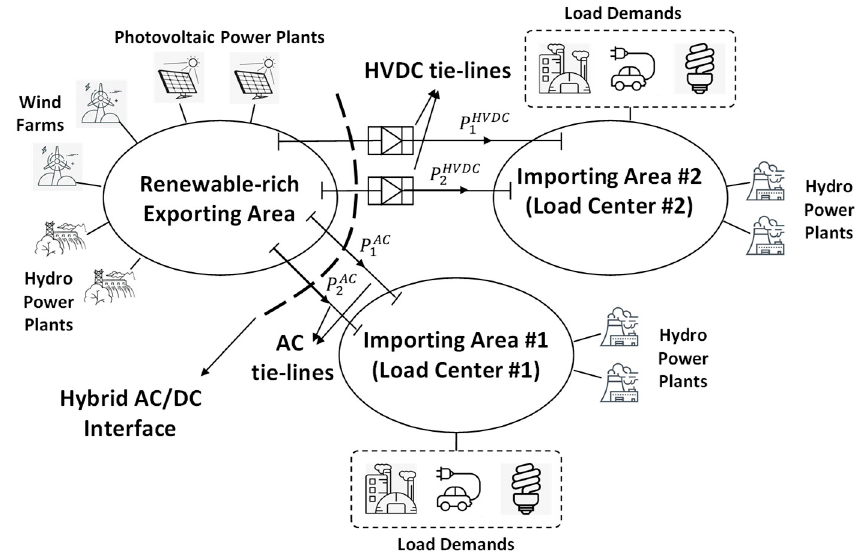
Figure 1. Demonstration of renewable-rich power grid with hybrid AC/DC interface.